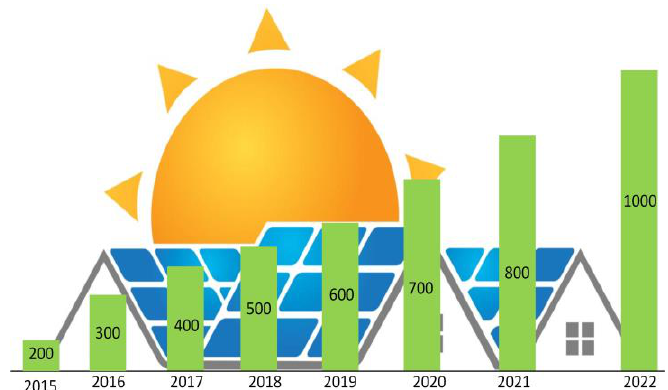
Figure 1. Evolution of the photovoltaic (PV) capacity (GW p ) around the globe from 2015 to 2022 [1].